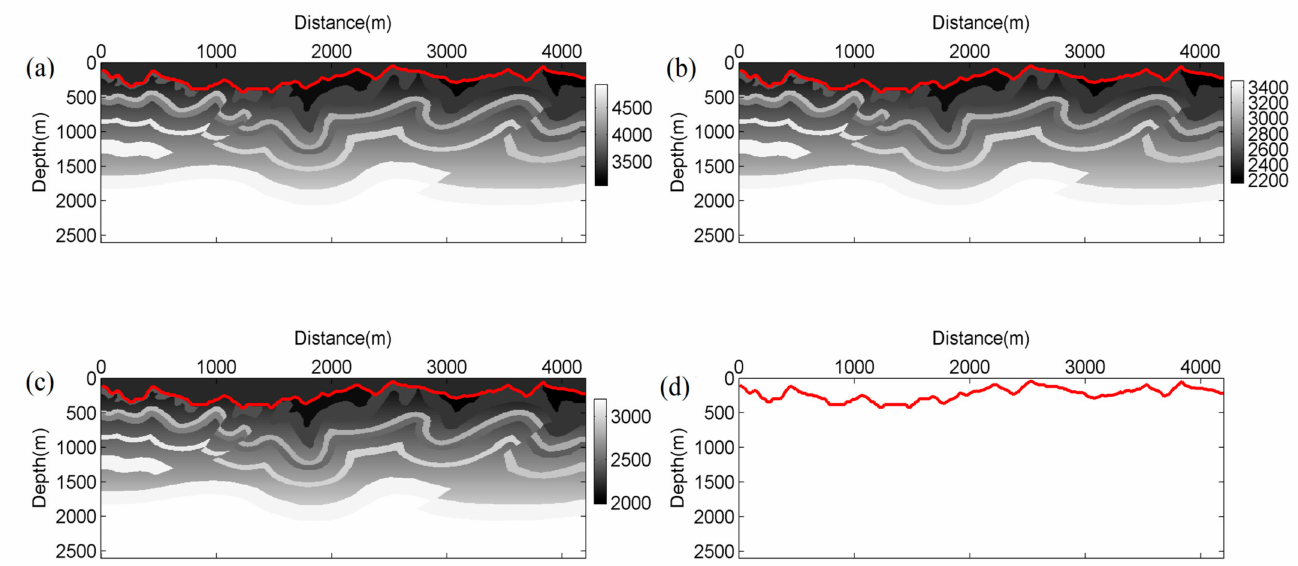
Figure 12. A modified Canadian Foothills elastic model with a complex topography: ( a ) V p model, ( b ) V s model, ( c ) ρ model, and ( d ) surface topography of the model. The red line is the surface